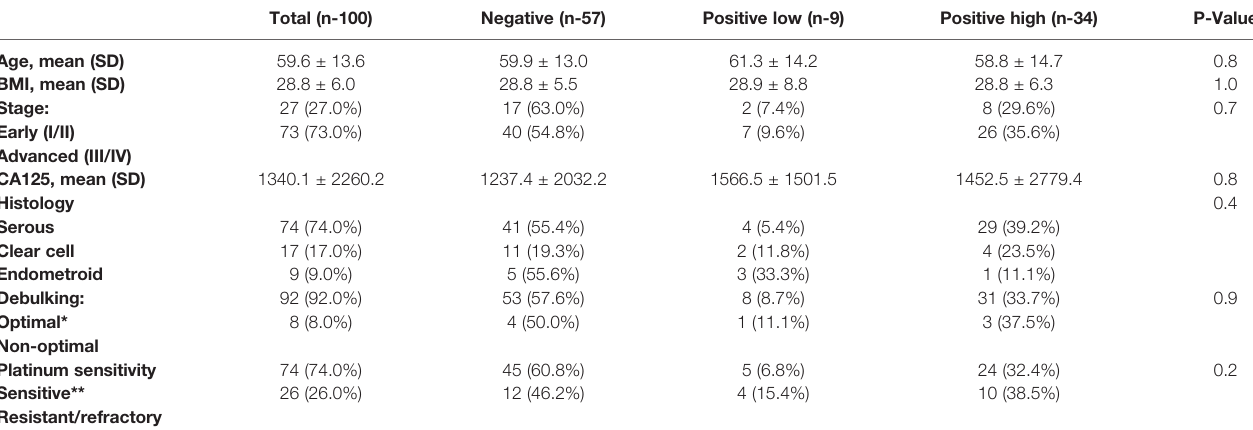
TABLE 2 | Baseline characteristics of the